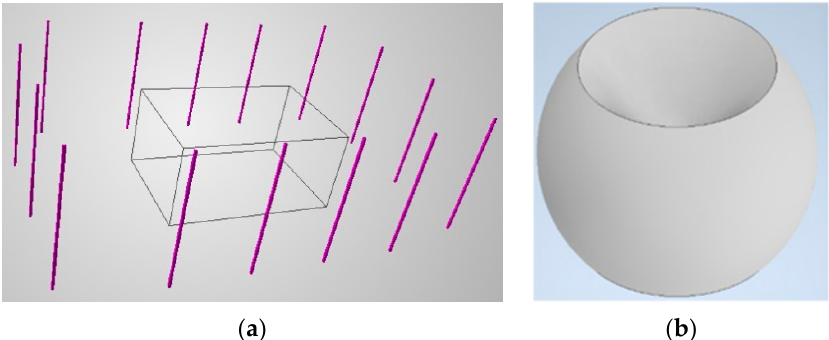
Figure 5. The example scene volumes: ( a ) measurement volume is presented as a black cuboid and permitted volume as segments for cameras to be mounted on as described in this paper. ( b ) Example of an angular range within which predictions are calculated (45–135 degrees in the polar direction, 0–360 degrees in azimuthal direction).